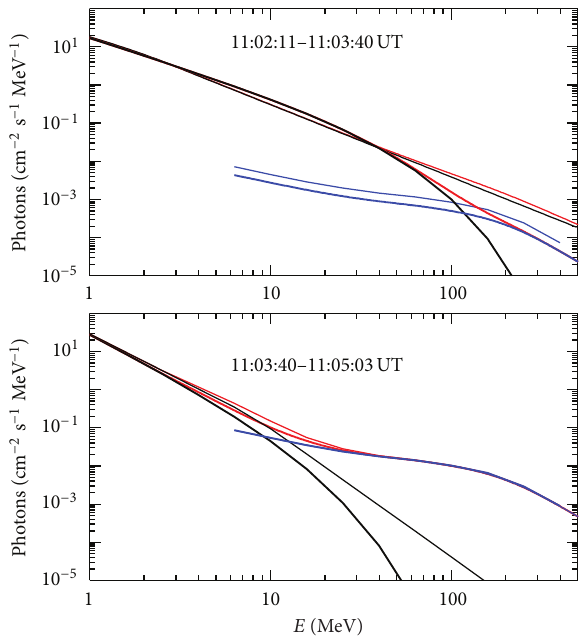
Figure 5: The restored incident gamma-ray spectra of the flare on October 28, 2003 (from [35]). Red curves represent the total spectra, black curves electron bremsstrahlung component, and blue curves the pion-decay gamma-ray spectrum. The thin curves correspond to a power law with varying index and the thick curves correspond to a power law with an exponential